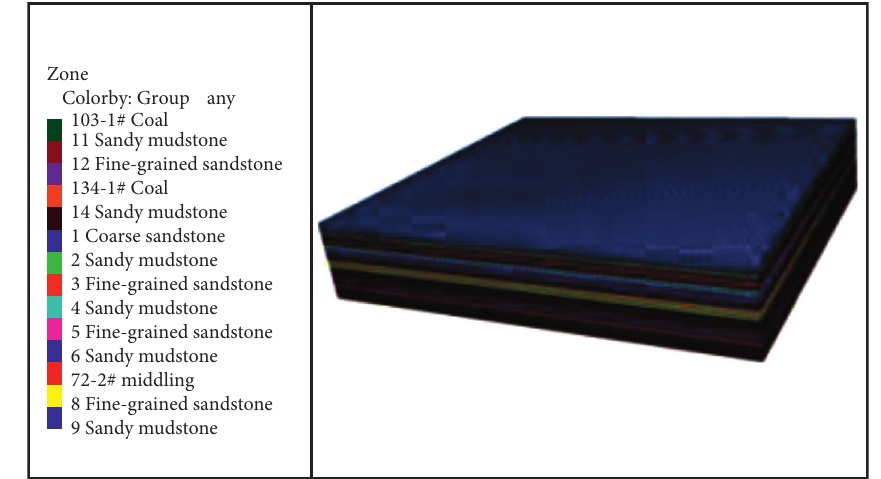
Figure 8: FLAC3D mining numerical simulation model. Table 2: Mechanical parameters of rock